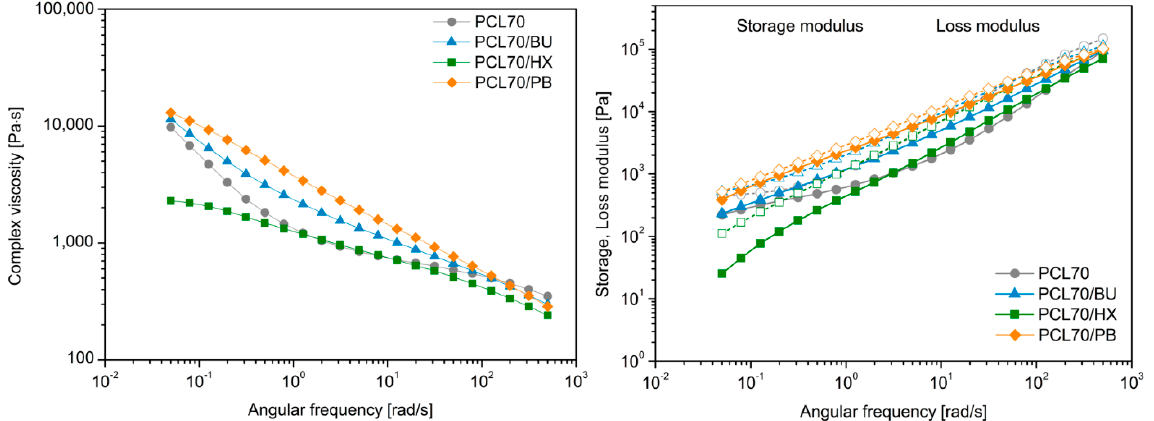
Figure 9. Complex viscosity, storage and loss modulus of unmodified PCL/PLA blends with weight ratio of 70/30 and modified by OP.